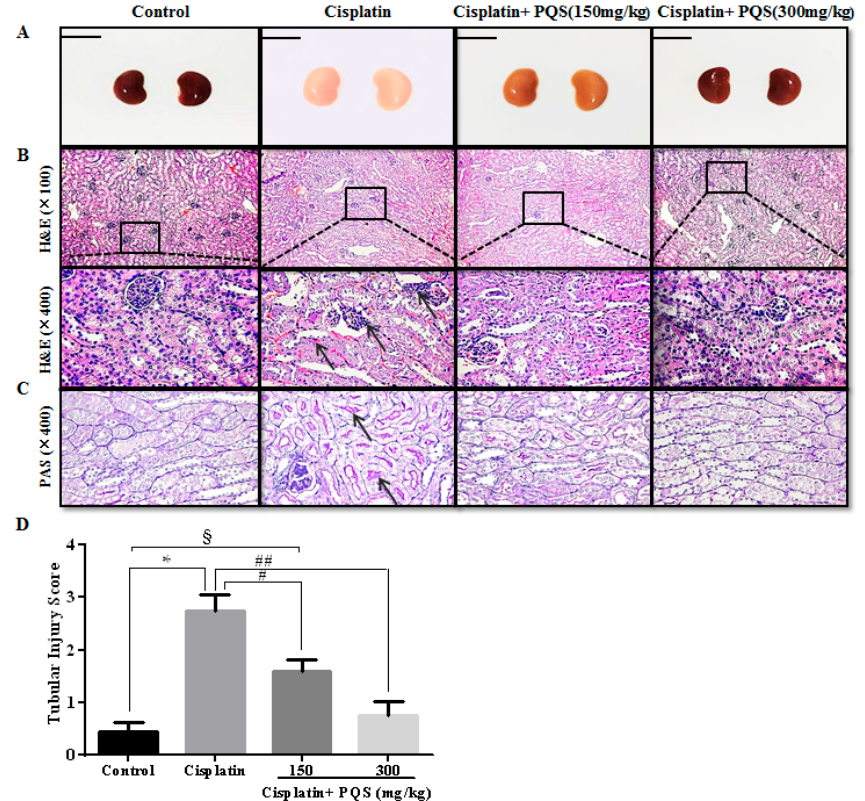
Figure 5. Morphological changes of the kidneys ( A ); histological examination of morphological changes in kidney tissues, renal tissues stained with H&E (100× and 400×) ( B ); arrows show necrotic cell and inflammatory infiltrate cells (PAS (400×)) and arrows show glycogen accumulation in renal tubules ( C ); and column chart shows renal tubular injury score ( D ). All data are expressed as mean ± S.D., n = 8. § p < 0.05, * p < 0.05 vs. control group; # p < 0.05, ## p < 0.01 vs. cisplatin group. Notes: periodic acid-schiff stain, PAS.